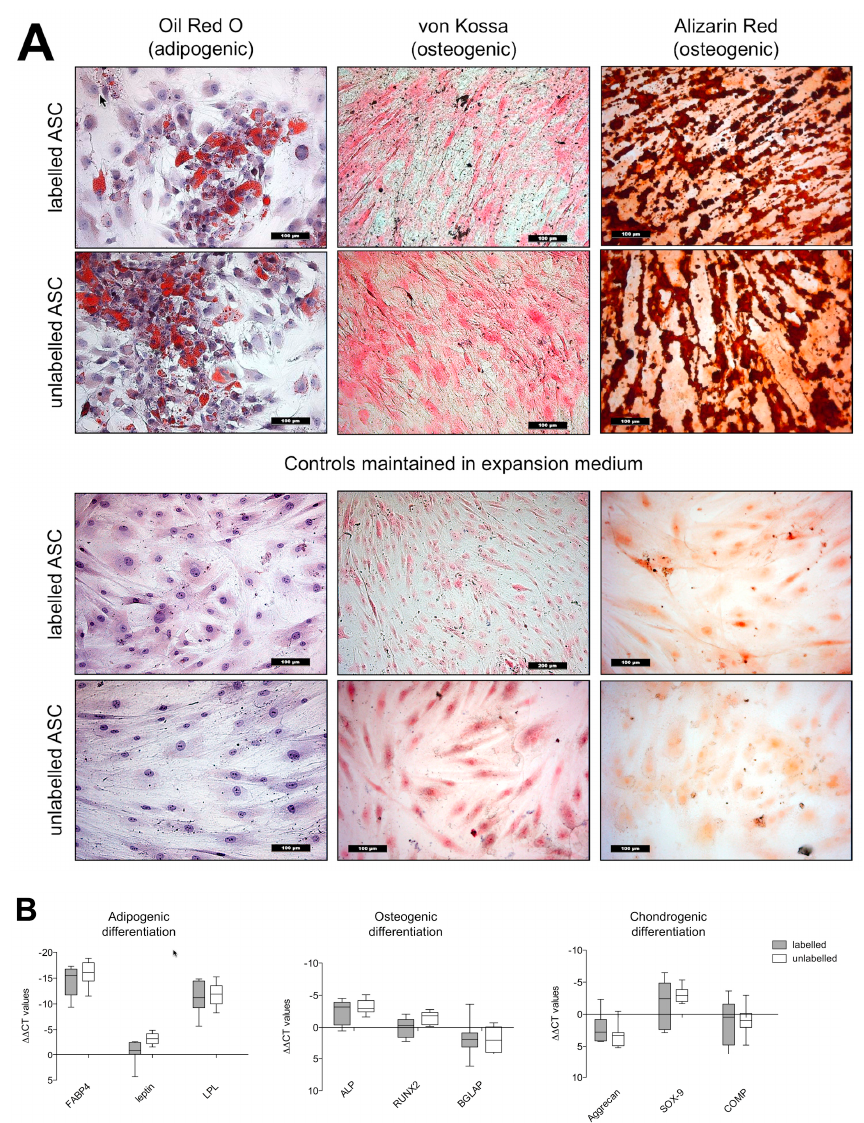
Figure 5. ( A ): Histological results of adipogenic and osteogenic di ff erentiation of labelled and unlabelled hASCs: Oil Red O-stained intracellular lipid droplets could be detected in both labelled and unlabelled cells after two weeks of adipogenic induction (first column). The deposition of calcified extracellular matrix was detected in VSOPs-labelled and unlabelled cells using von Kossa (second column) and Alizarin Red (third column) staining after osteogenic di ff erentiation. There was no noticeable di ff erence in both groups. Labelled and unlabelled hASCs, maintained in an expansion medium, showed neither intracellular lipid vacuoles nor extracellular calcium deposits (row 3 and 4). Magnification × 200 in all figures; scale bars represent 100 µ m. ( B ) Real-time Polymerase Chain Reaction (PCR) analyses of the multidi ff erentiation potential: The gene expression of specific markers was determined after adipogenic, osteogenic and chondrogenic di ff erentiation by VSOPs-labelled and unlabelled hASCs. Relative quantification was performed and presented as values ( ∆∆ CT values), normalized to the gene expression of the housekeeping gene GAPDH and the gene expression of undi ff erentiated hASCs. VSOP-labelled and unlabelled hASCs showed no di ff erences in the expression of FABP4, leptin and LPL after adipogenic induction. In addition, the expression of the osteogenic marker genes ALP, RUNX2 and BGLAP, as well as the chondrogenic marker genes aggrecan, SOX-9 and COMP, did not di ff er in both groups. Box-Whisker plots show median, 1st quartile, 3rd quartile as well as minimal and maximal values of ∆∆